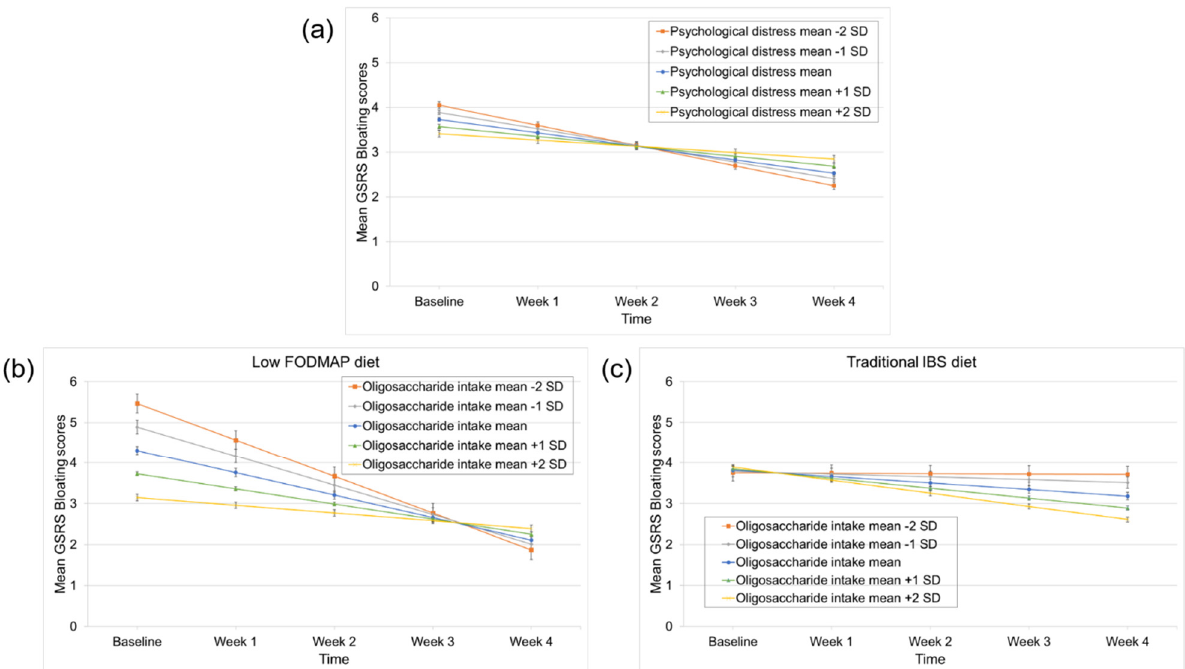
Figure 4. Predictors of bloating improvement during the low FODMAP and traditional IBS diet. ( a ) Higher psychological distress predicted worse response to both diets. ( b ) Oligosaccharide intake was a differential predictor with a significant association between higher baseline oligosaccharide intake and a worse response in low FODMAP treatment arm and ( c ) a non-significant association between higher baseline oligosaccharide intake and a better response in traditional IBS treatment arm. The GSRS-IBS subscales used in the linear mixed (i.e., random-effect) models were BoxCox transformed. For the transformation of the bloating subscale, the following BoxCox formula was used: y ( λ ) = y . This led to changes in the original score range score of 1–7 to 0–6, using the formula: y ( 1 ) = y 1